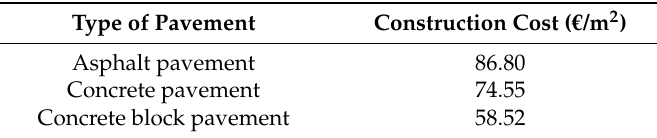
Table 14. Construction costs of each designed pavement.